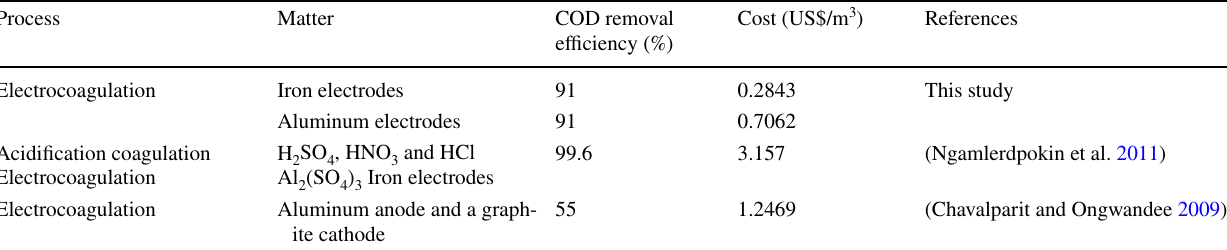
Table 4 The treatability of biodiesel wastewaters by different methods